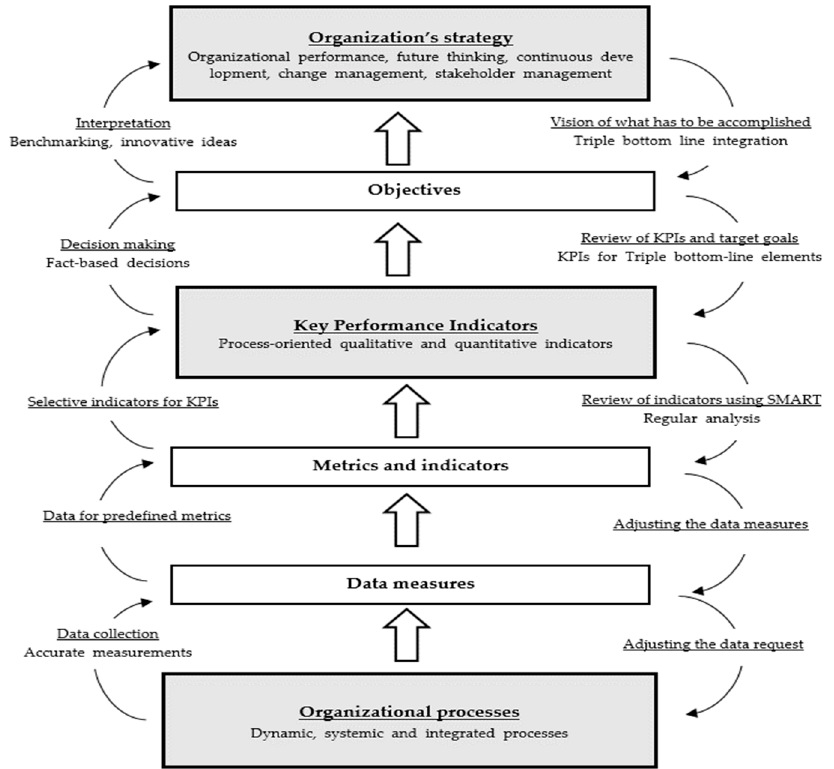
Figure 1. The linkage between the organization’s strategy, key performance indicators (KPIs) and processes (created by the authors).